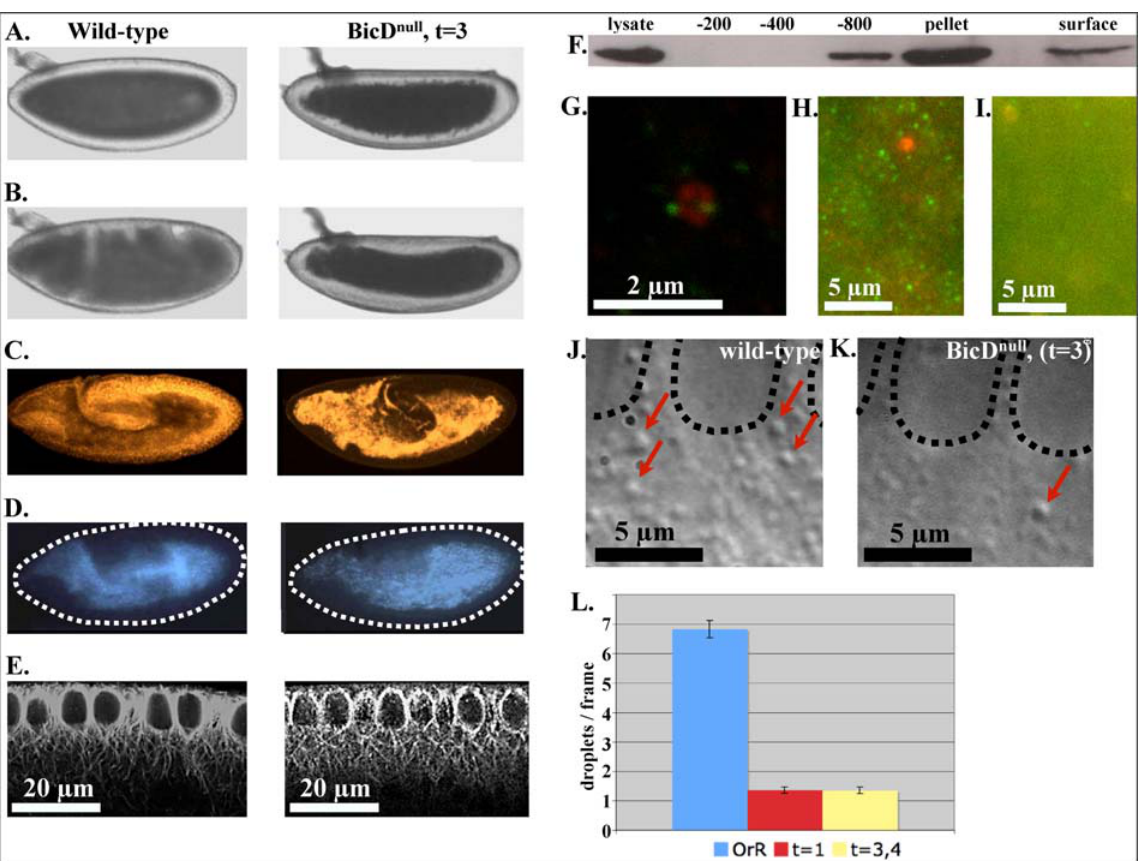
Figure 2. Lowering BicD expression has a net effect on lipid droplet transport. A and B: Transmitted light images of developing BicD null (t=3) embryos indicate proper lipid droplet clearing in phase II (A), but an inability to recloud in phase III (B). C: Prior to Phase 3, during germband extension, the neutral-lipid specific dye Nile Red shows a net position of lipid droplets which is very different between wild-type and BicD null embryos. D: During germband extension, DAPI autoflouresence of yolk vesicles does not indicate a significantly different positioning of these cargoes. Dashed lines delineate the embryos edge. E: No gross defects are observed in the MT structure of mutant embryos, as exemplified by the above image of MT immunoflouresence. Both images show microtubules passing from above, between, and below the syncytial nuclei. F: BicD localizes to the layer of lipid droplets which spin up through a sucrose gradient during centrifugation from an initial embryo lysate due to their bouyent density. Equal volumes of extracted sample were loaded per lane of the western. BicD signal can be found in the pellet, the layer immediately above the pellet (-800), and at the surface where lipid droplets coalesce. G: Confocal analysis of whole fixed embryos shows some BicD signal (green) close to droplets (red). Red signal represents the droplets specific marker LSD2. Lipid droplets generally average approximately 500 nm in size. H and I: With less magnification, standard fluorescence microscopy shows significant punctual staining of the cytoplasm in Phase I wild-type embryos (H) but not in Phase I, BicD null (t=3) embryos (I). Here, green is BicD, and red is the lipid droplet specific protein LSD2. J and K: Phase II DIC images show a clear difference in the number of lipid droplets near the nuclei. Dashed lines specify the position of the nuclei and red arrows are shown indicating the position of several lipid droplets. L: Automated analysis of the number of droplets observed per frame, in phase II, confirms the apparent decrease in droplets seen at the periphery of the embryo in ‘t=1’ and ‘t=3–4’ mutant backgrounds.